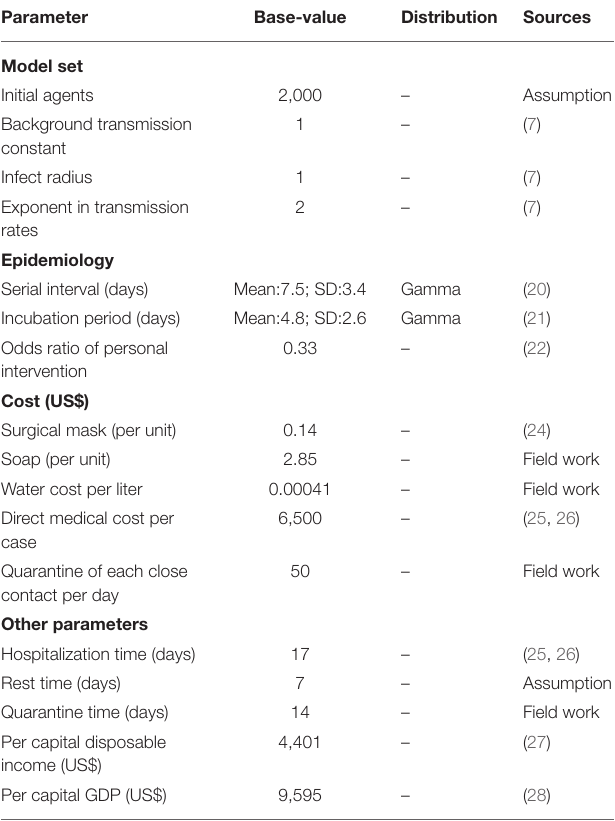
TABLE 1 | Parameters in the ABM